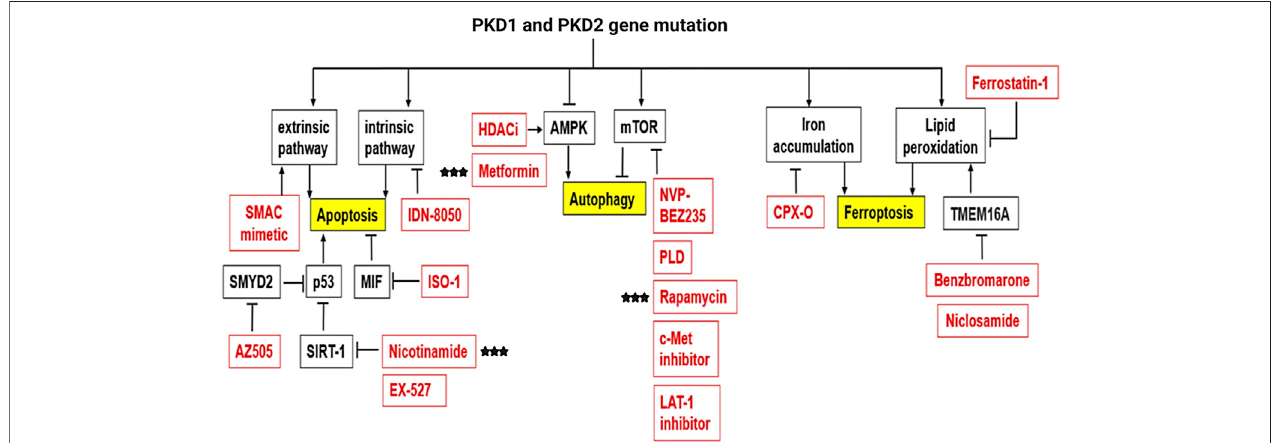
FIGURE 5 | Cell death pathway and the drug targets in ADPKD. In ADPKD, mutation of PKD1/PKD2 causes dysregulation of cell death, including apoptosis, autophagy and ferroptosis. Apoptosis is regulated through extrinsic pathway and intrinsic pathway. Treatment with SMAC mimetic activates apoptosis through an extrinsic dependent pathway to delay cyst growth, while treatment with pan-caspases inhibitor IDN-8050 inhibits apoptosis through an intrinsic pathway which also reduces cyst size. Treatment with SIRT-1 inhibitors, including nicotinamide and EX-527, and Smyd2 inhibitor, AZ505, as well as MIF inhibitor, ISO-1, induced apoptosisinap53dependentmanneranddelaycystgrowth.AutophagyisregulatedthroughPKDassociatedAMPKandmTORpathways.Treatmentwithinhibitorsof mTOR pathway, including NVP-BEZ236, PLD and rapamycin as well as c-Met and LAT-1 inhibitors, delays cyst growth, and treatment with AMPK inducers, metformin andHDACi,alsoslowscystgrowth.Ferroptosisisanirondependentcelldeathcharacterizedwiththeincreaseoflipidperoxidation.TreatmentwithCPX-O,achelatorof iron, inhibited cystogenesis. Treatment with ferroptosis inhibitor, Ferrostatin-1, delays cyst growth and cystic cell proliferation. TMEM16A can induce lipid peroxidation, and treatment with TMEM16A inhibitor, niclosamide and benzbromarone, signi fi cantly reduced renal cyst size in ADPKD animals (Three black stars indicate drugs in clinical